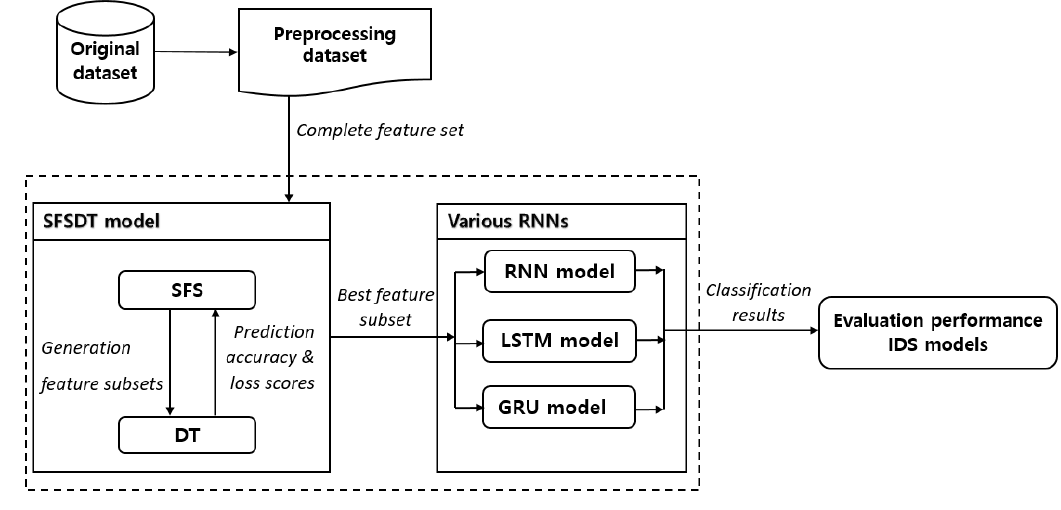
Figure 1. The proposed IDS